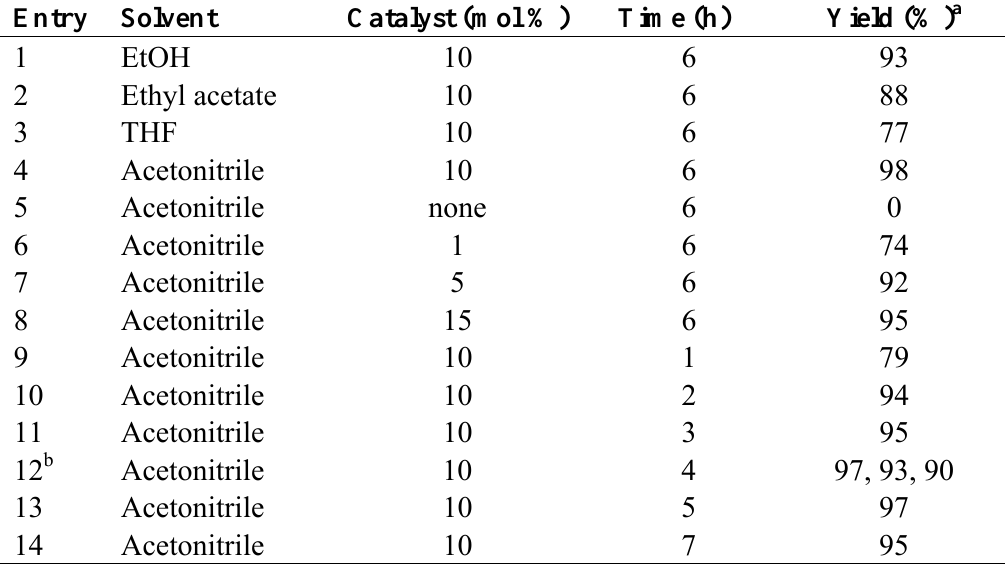
Table 1. Effect of the catalyst [PyN(CH for the reaction of indole and